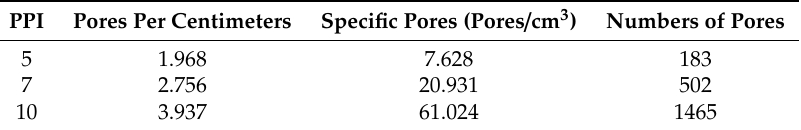
Table 1. Number of pores of foams designed in this work.